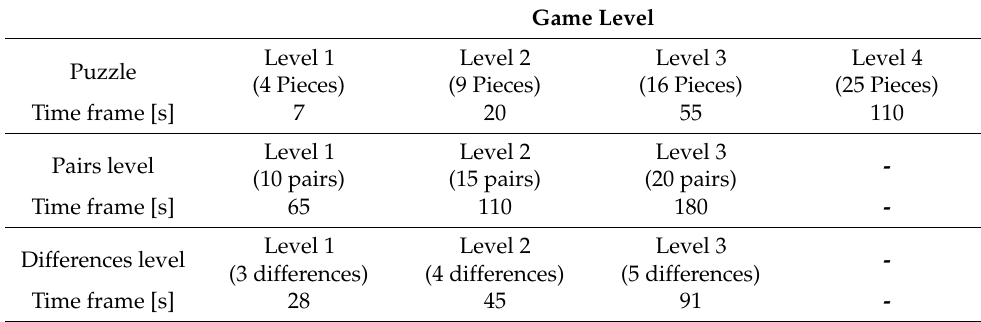
Table 1. Time frames for the games.